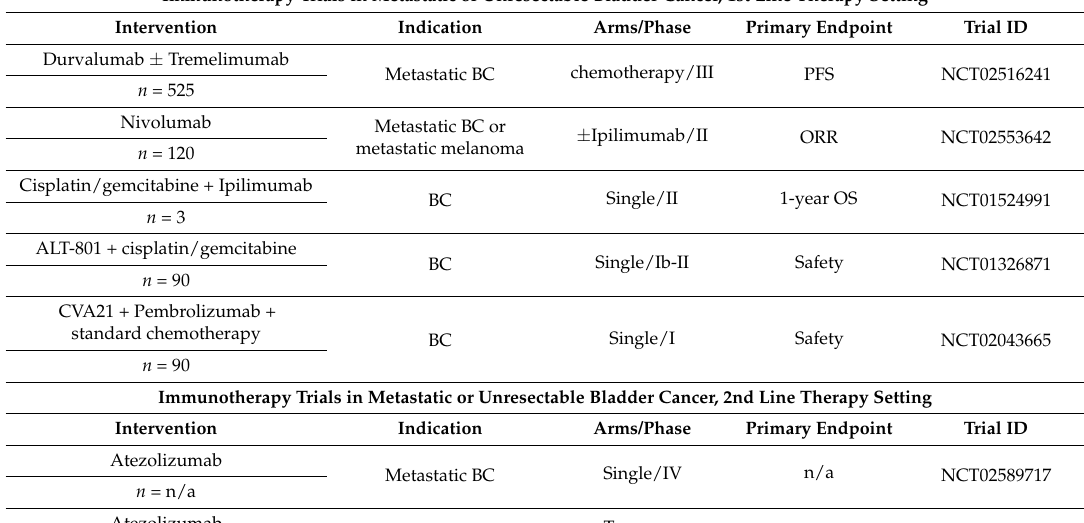
Table 1. Ongoing immunotherapy trials in advanced/metastatic urothelial